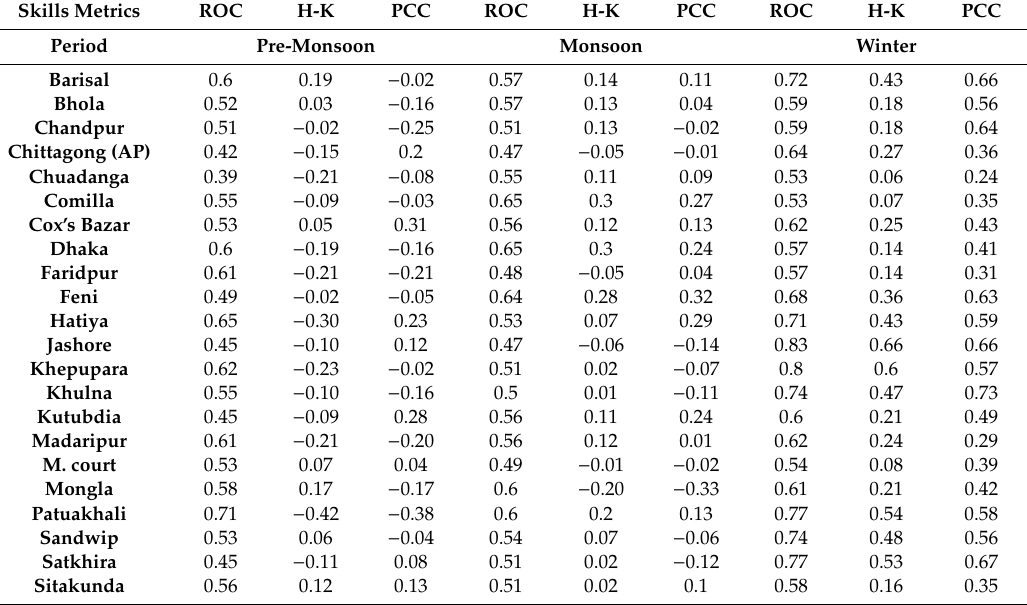
Table A3. Skills assessment metrics (ROC, H-K and PCC) for all stations under lead time 0-months. Skills